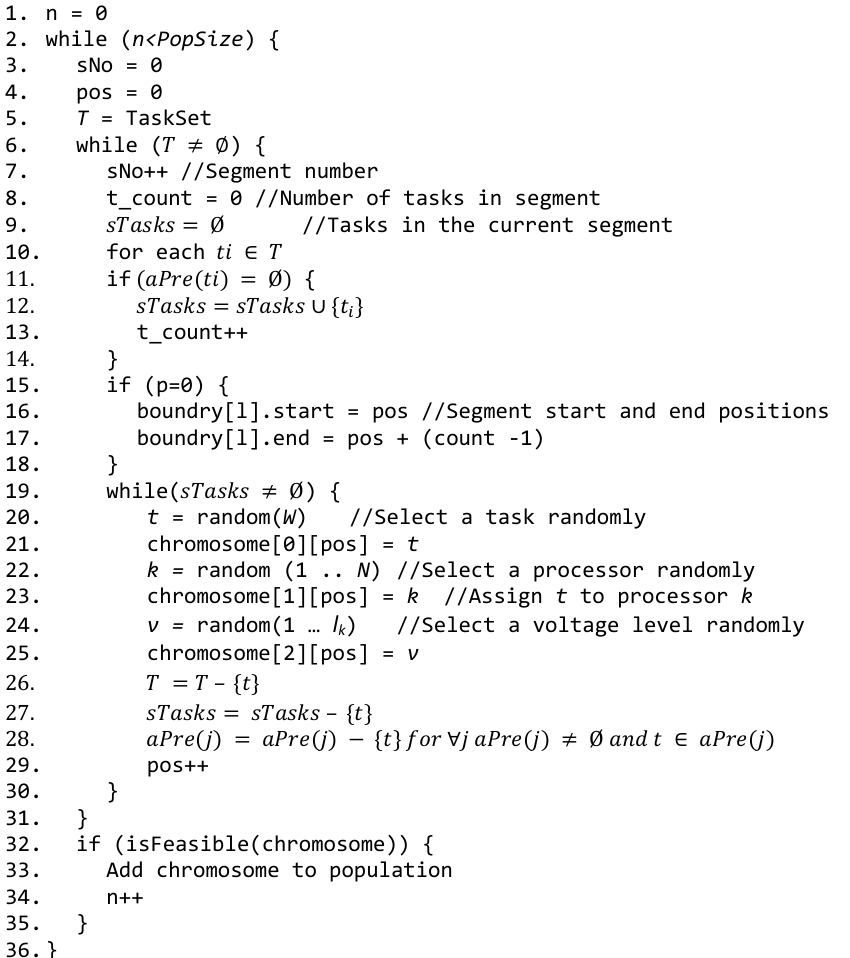
Figure 5. The initial solution generation algorithm.